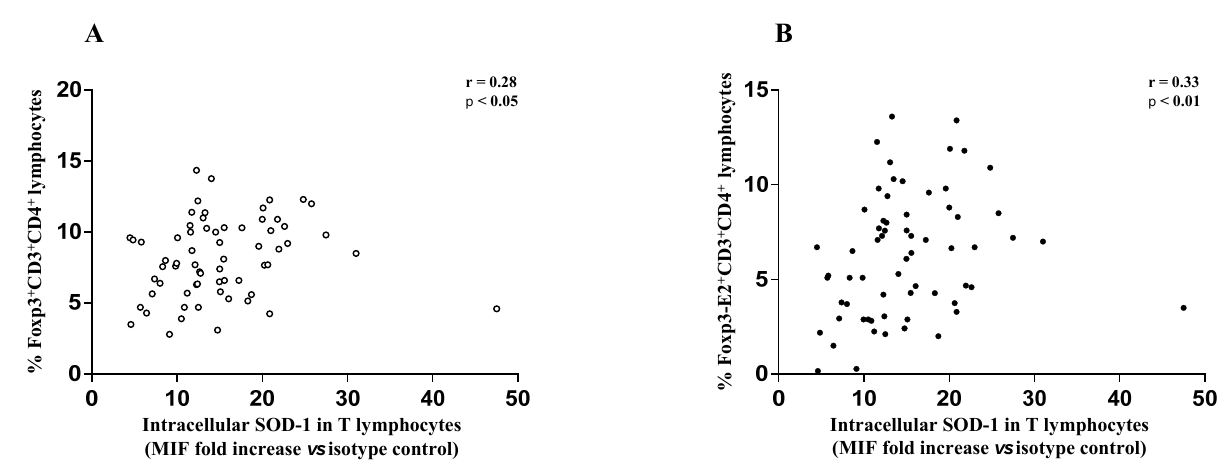
Figure 4. ( A ) Scatter plot showing positive correlation between the frequency of circulating Foxp3-expressing CD4 + T lymphocytes and intracellular SOD-1 content in T cells of MS-RR individuals undergoing immune-modulating treatments, except fingolimod; (r = 0.28; 95% confidence interval (CI) = 0.03 to 0.49 by two-tailed Spearman correlation p < 0.05). ( B ) Scatter plot showing positive correlation between the frequency of circulating Foxp3-E2-expressing CD4 + T lymphocytes and intracellular SOD-1 content in T cells of MS-RR individuals undergoing immune-modulating treatments, except fingolimod; (r = 0.33; 95% CI = 0.091 to 0.54 by two-tailed Spearman correlation; p <